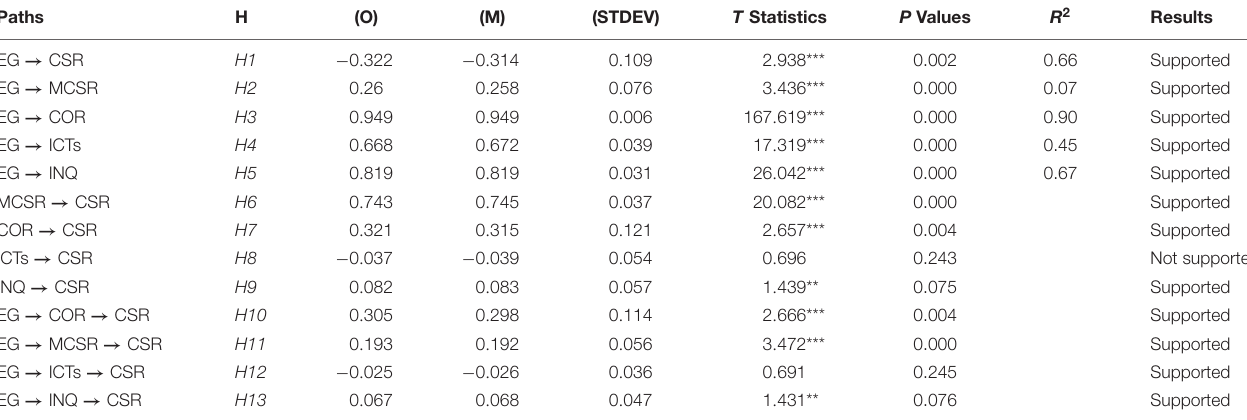
TABLE 5 | Direct and indirect effects. Paths